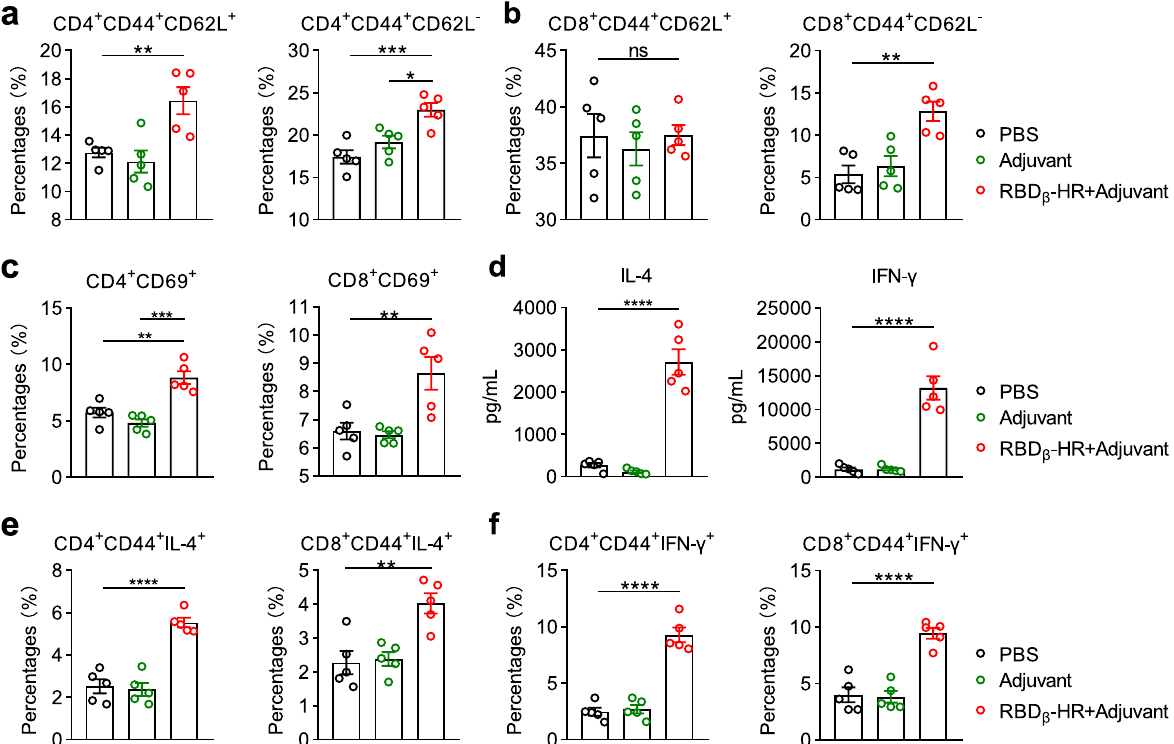
Fig. 5 RBD β -HR/trimer vaccine elicits robust cellular immune response. Mice immunized with PBS, MF59-like adjuvant, and RBD β -HR/trimer vaccine were sacrificed on day 49. a The percentages of central memory CD4 + T cells (left) and effector memory CD4 + T cells (right) in the spleens. b The percentages of central memory CD8 + T cells (left) and effector memory CD8 + T cells (right) in the spleens. c The percentages of activated CD4 + T cells (left) and activated CD8 + T cells (right) in the spleens. d Cytokines secreted by the spleen lymphocytes into the supernatants after stimulation with RBD β -HR/trimer protein for 72 h. e The percentages of memory CD4 + T cells (left) and memory CD8 + T cells (right) secreted IL-4 in the spleen lymphocytes after stimulation with RBD β -HR protein for 72 h. f The percentages of memory CD4 + T cells (left) and memory CD8 + T cells (right) secreted IFN-γ in the spleen lymphocytes after stimulation with RBD β -HR/trimer protein for 72 h. Data are mean considered statistically significant (* p < 0.05; ** p < 0.01; *** p < 0.001; **** p <